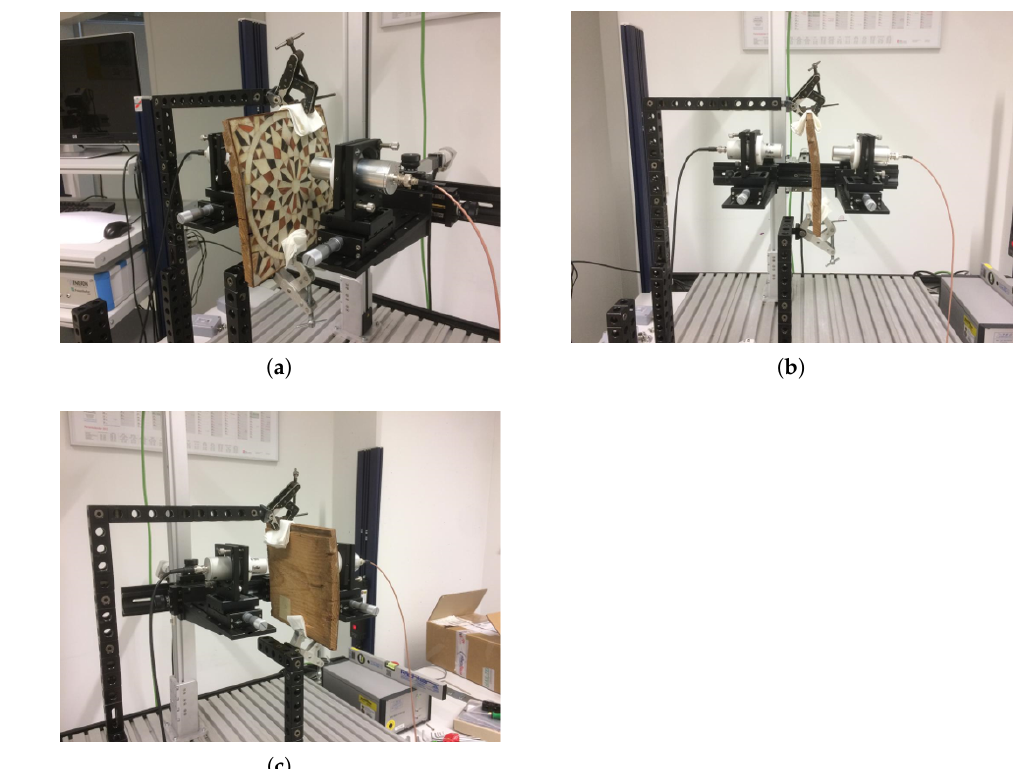
Figure 2. Air-UT setup. ( a ) Front view, ( b ) lateral view, and ( c ) back